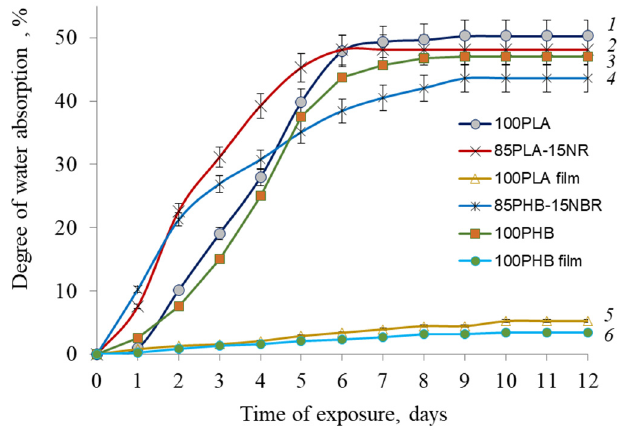
Figure 3. Water uptake of nonwoven fabrics: PLA (1), 90PLA/15NR (2), PHB (3), 90PHB/15NBR (4), and films: PLA (5) and PHB (6).